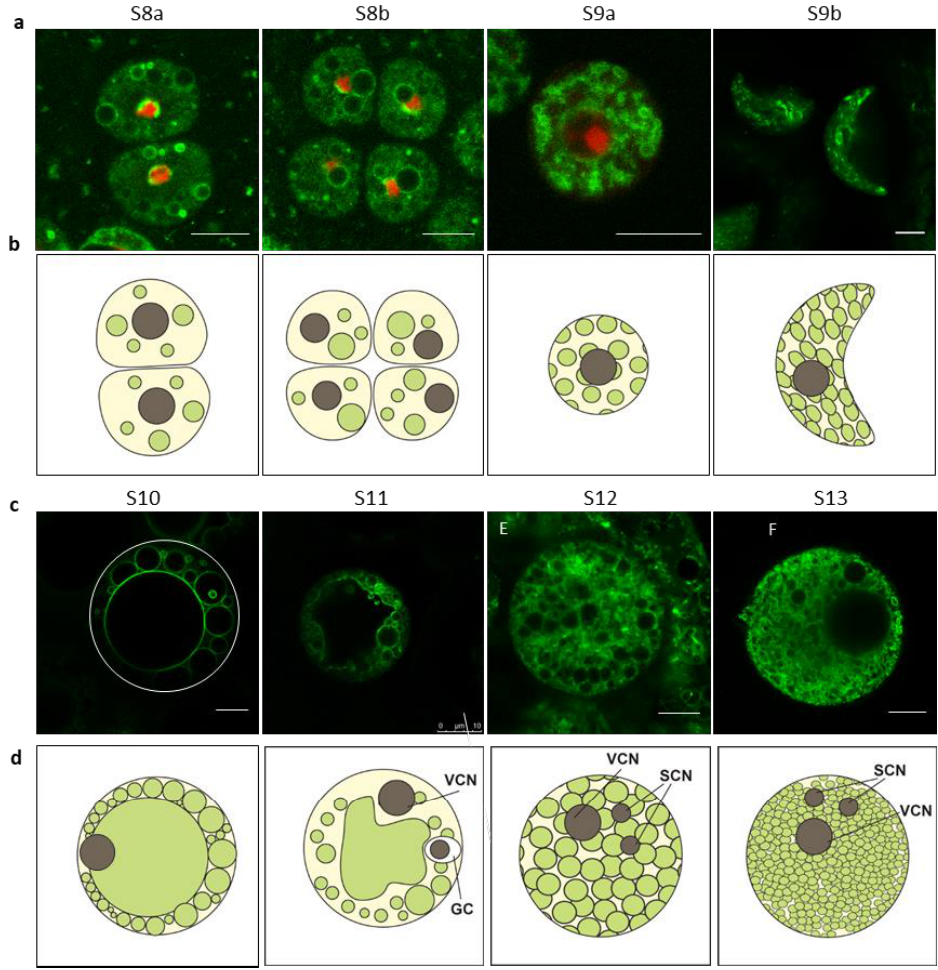
Figure 3. Vacuole morphology changes during microspore development. ( a,c ) Vacuole morphology progression, observed by confocal microscope, during different microspore developmental stages. Scale bars: 10 µm. White line enclosure indicates the cell edge (in ( c ); left panel). ( b,d ) Schematic views of the vacuole progression in microspores based on multiple confocal observations ( n > 3). The shapes filled with green represent the vacuoles. VCN: vegetative cell nucleus. GC: generative cell. SCN: sperm cell nucleus. The scale is relative ( b , d ).